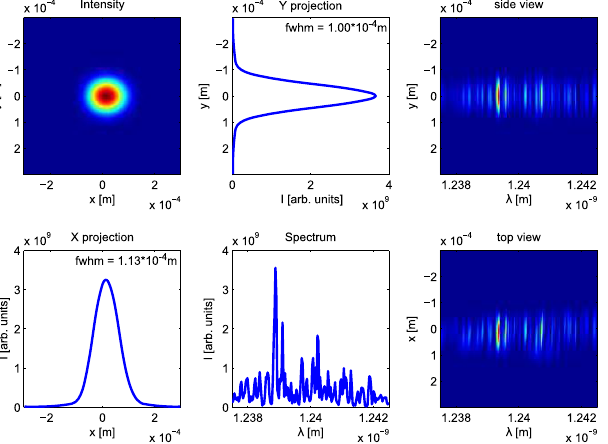
FIG. 10. Radiation distribution at the entrance of seeded undulator in frequency domain.